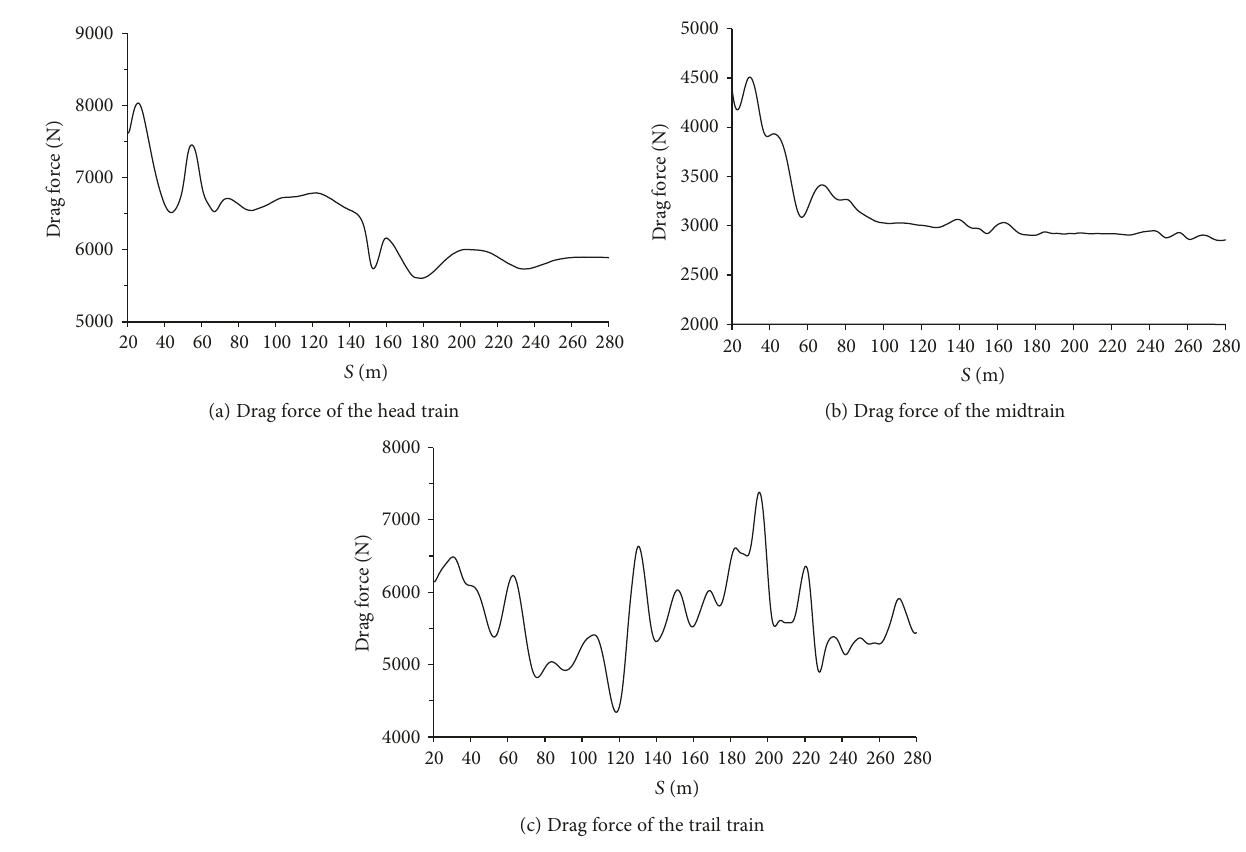
Figure 15: Changing of aerodynamic drag force of each train